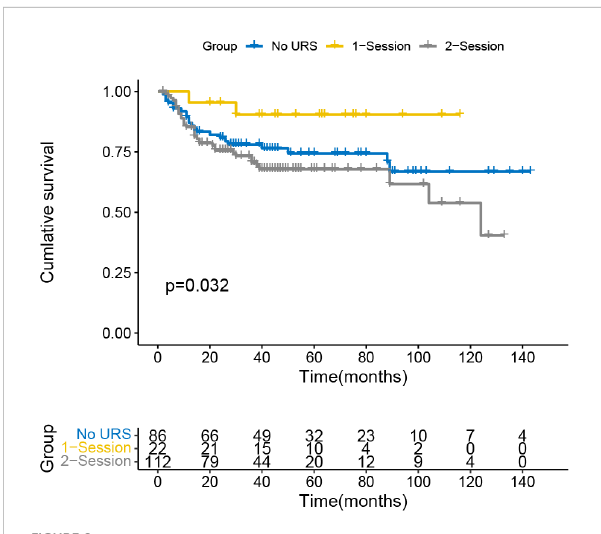
FIGURE 2 Survival analysis of extraurothelial recurrence in all patients.